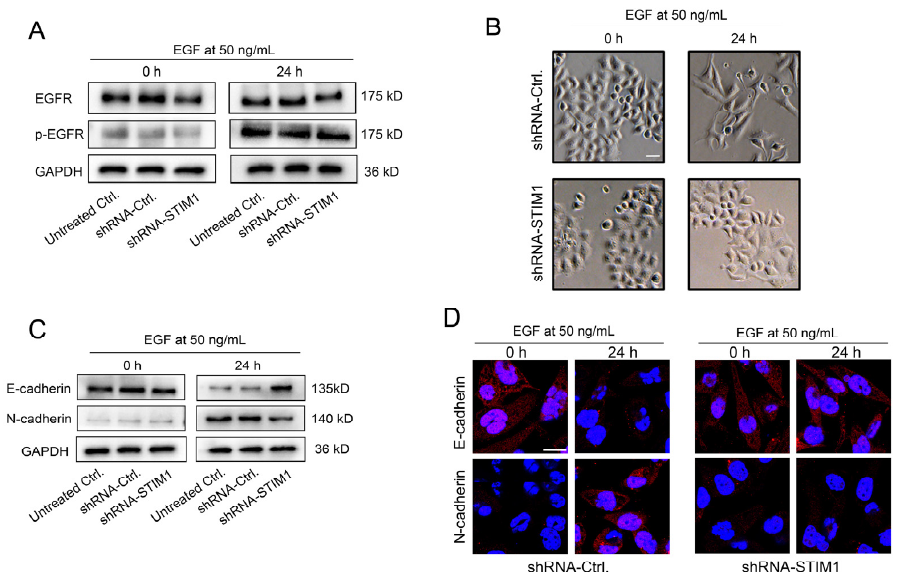
Figure 2. Knockdown of STIM1 inhibits the EGFR activation-stimulated switch from E- to N-cadherin. ( A ) The effect of STIM1 knockdown on EGFR expression and phosphorylation was evaluated using Western blotting. The shRNA-untreated cells served as blank controls. ( B ) Morphological changes in 5–8F cells transfected with lentiviral vectors carrying shRNA-Ctrl or shRNA-STIM1 before and after EGF stimulation. Bar = 20 μ m. ( C ) The effect of STIM1 knockdown on the EGF-stimulated switch from E-cadherin to N-cadherin was examined using Western blotting. ( D ) Changes in the expression of E-cadherin and N-cadherin were determined using cellular immunofluorescence. Bar = 10 μ m.